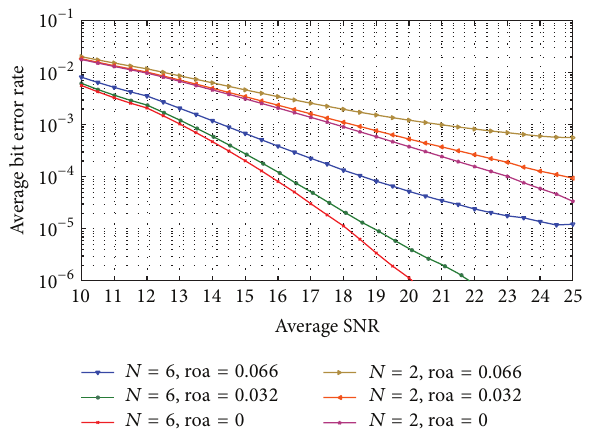
Figure 9: The average probability of bit error of code-time diversity system in Rayleigh frequency selective fading channel with 𝑁 = 2 and 𝐿 = 2 , using orthogonal and nonorthogonal spreading